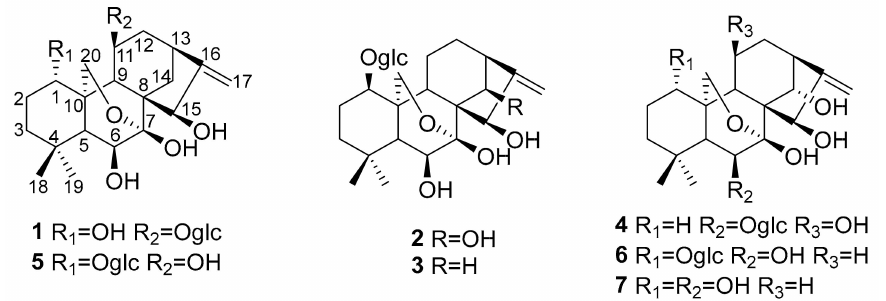
Figure 1. Structures of Compounds 1 – 7